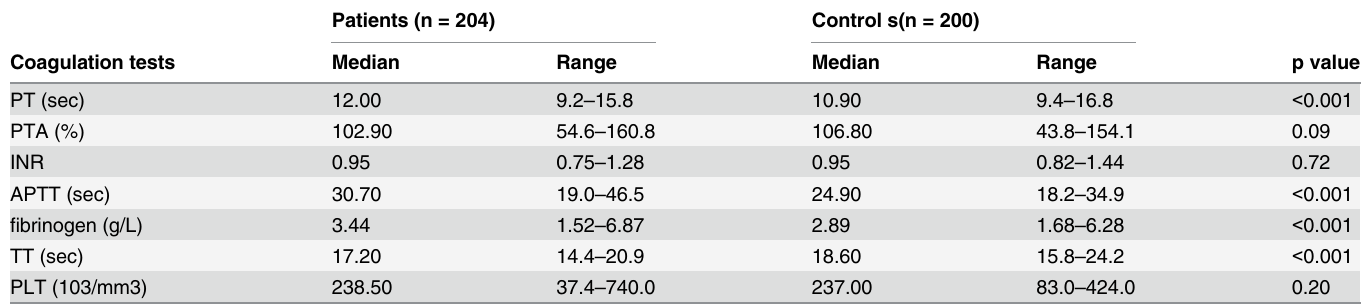
Table 1. The serum coagulation tests results in patients with ESCC and healthy